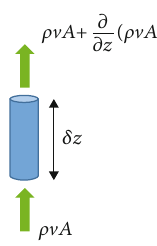
Figure 4: Schematic of inner model and outer model.